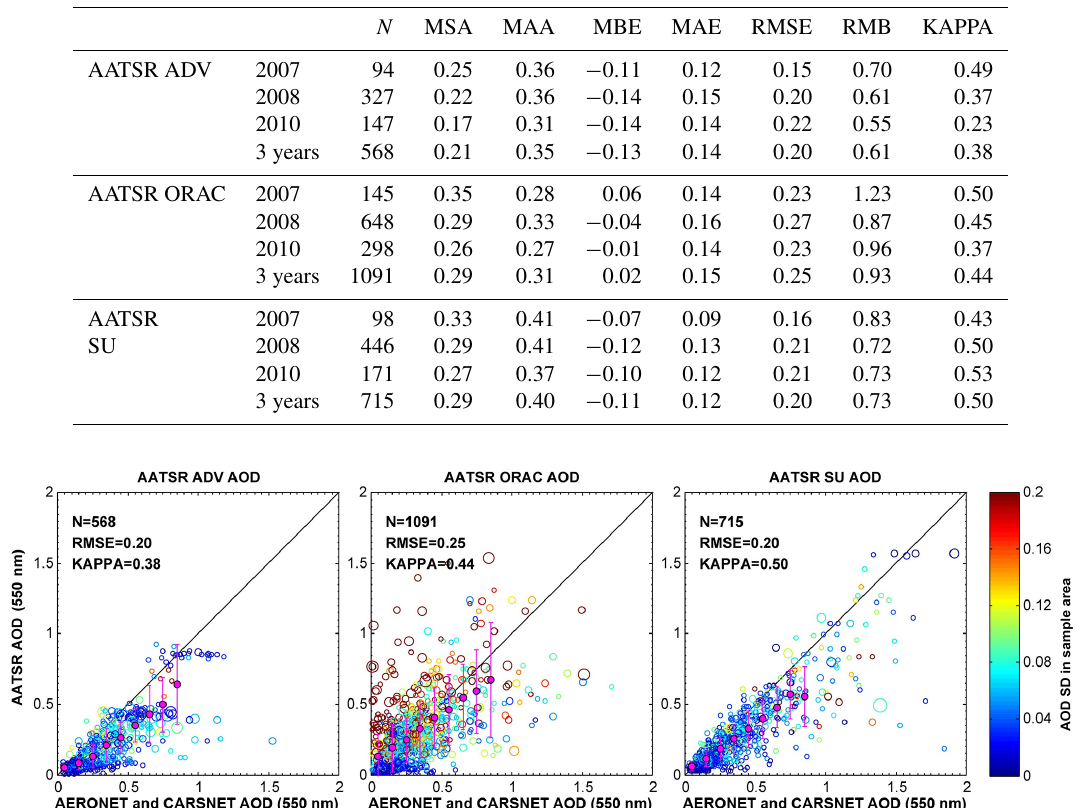
Figure 2. Scatter plots of AATSR ADV, ORAC, and SU L2 AOD products with ground-based data in China for the 3 years of 2007, 2008, and 2010. The black solid line represents the 1–1 line. The magenta points are means for specific ranges of AERONET and CARSNET AOD, and the magenta lines are the mean ± 2 σ of retrievals in a certain range. The areas and colours are determined by the means of uncertainty (MU) dataset in AATSR L2 products and the standard deviation of retrievals (Std_S) in a collocation frame of 50km × 50km, respectively.